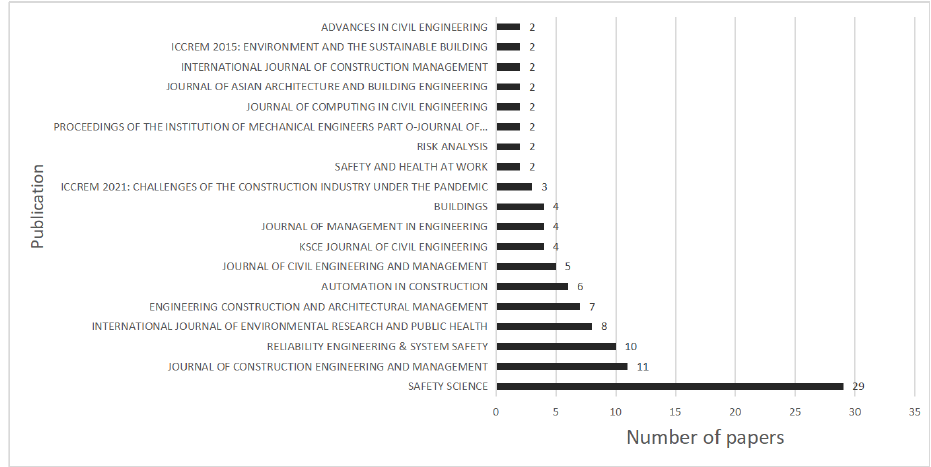
Figure 3. Numbers of papers published in major journals (n ≥ 2).